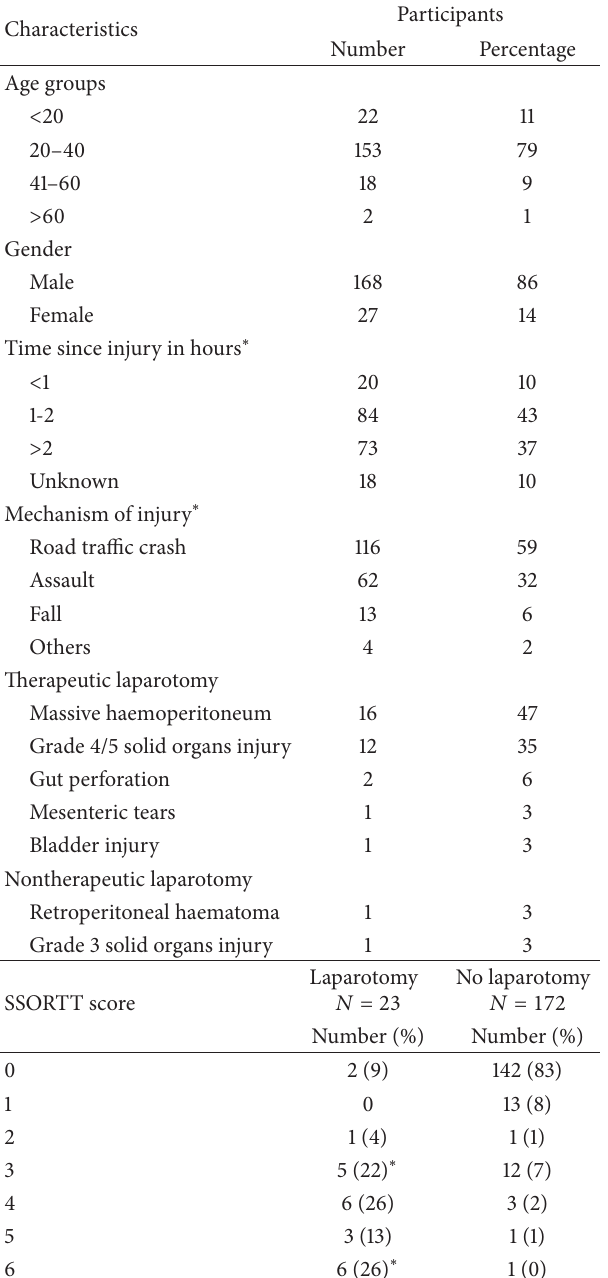
Table 1: Distribution of baseline characteristics and laparotomy findings for the 195 participants.